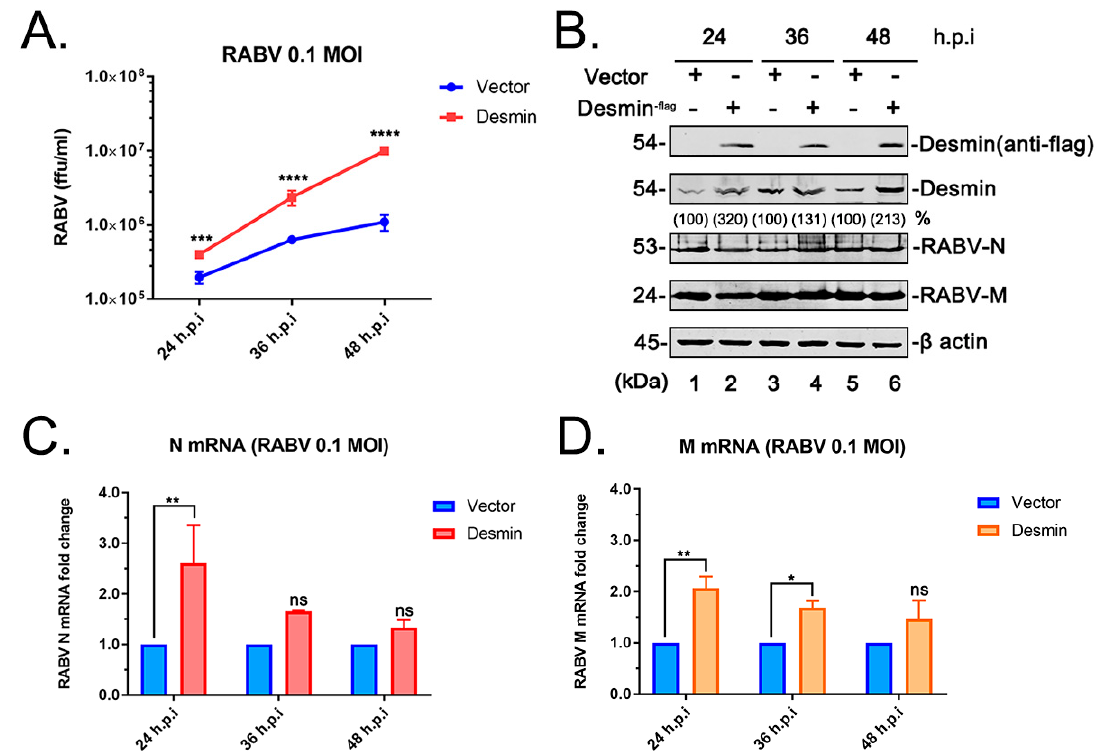
Figure 2. Exogenously expressed desmin facilitates RABV infection. BHK-21 cells were transfected with vector or plasmid encoding flag-tagged desmin, followed by infection with RABV (RC-HL strain) at an MOI of 0.1. ( A ) Virus titration of the supernatants from infected cells at 24, 36, and 48 h post infection (h.p.i). ( B ) Western blotting analysis of desmin and viral proteins RABV-N and M, with β -actin serving as a control, the indicated proteins were quantified using NIH Image-J software (1.53m 28, MD, USA). The infected cell extracts were harvested at 24, 36, and 48 h.p.i. ( C , D ) RABV-N ( C ) and RABV-M ( D ) mRNA expression levels were analyzed via qRT-PCR at 24, 36, and 48 h.p.i. Data were normalized to β -actin mRNA expression and are presented as relative fold change vs. controls. Statistical significance of bar graphs was analyzed by unpaired t -test with Welch’s